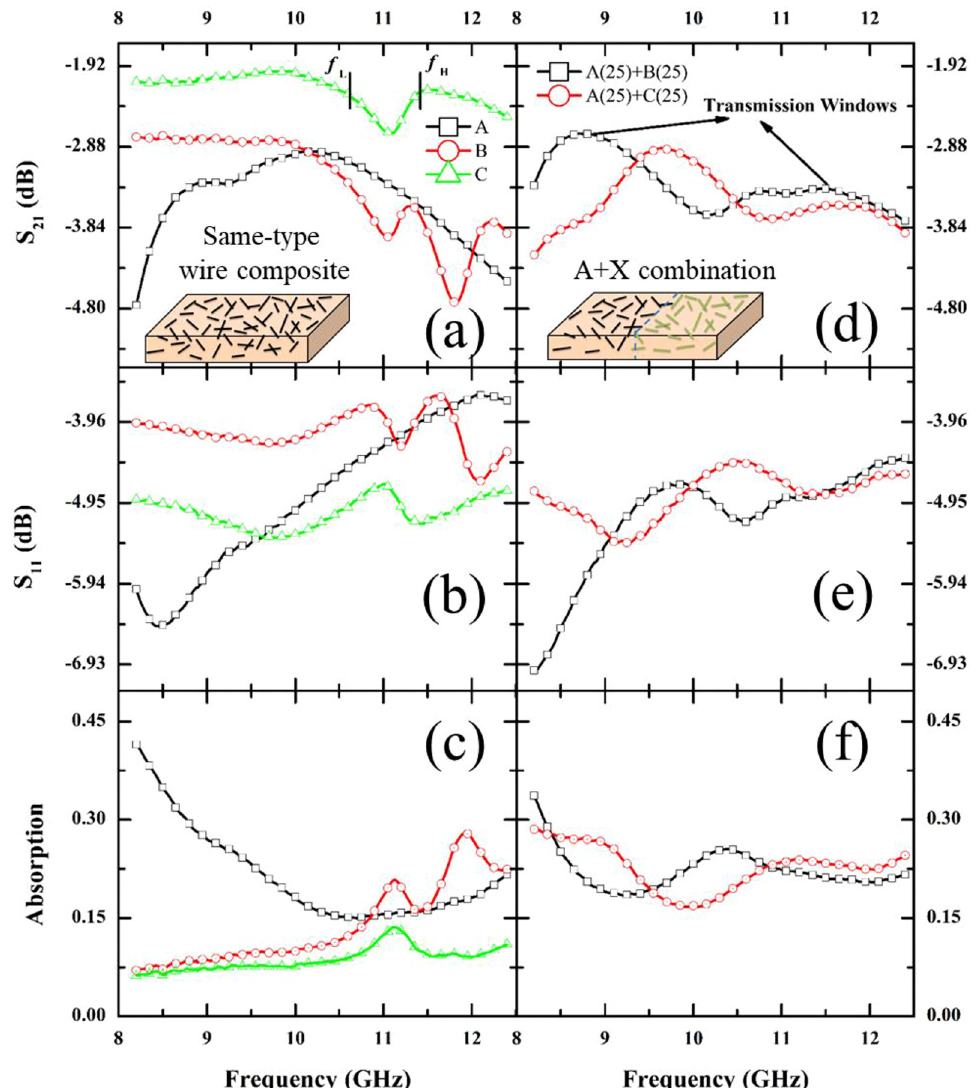
Fig. 5. Scattering properties: transmission S 21 , re fl ection S 11, and absorption of the composites containing only one type of wires (left panel) and an equal combination of as-cast A and annealed X (right panel) randomly dispersed short-cut microwires. The labels f L and f H correspond to the two cut-off, frequency points of the stopband